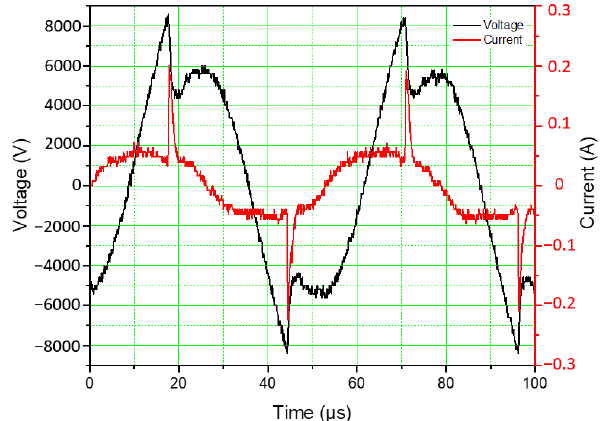
Figure 2. Discharge voltage and current profiles at a flow rate of 0.5 LPM with a CO 2 :CH 4 ratio of 50:50 (v%/v%) for a timespan of 100 µs.